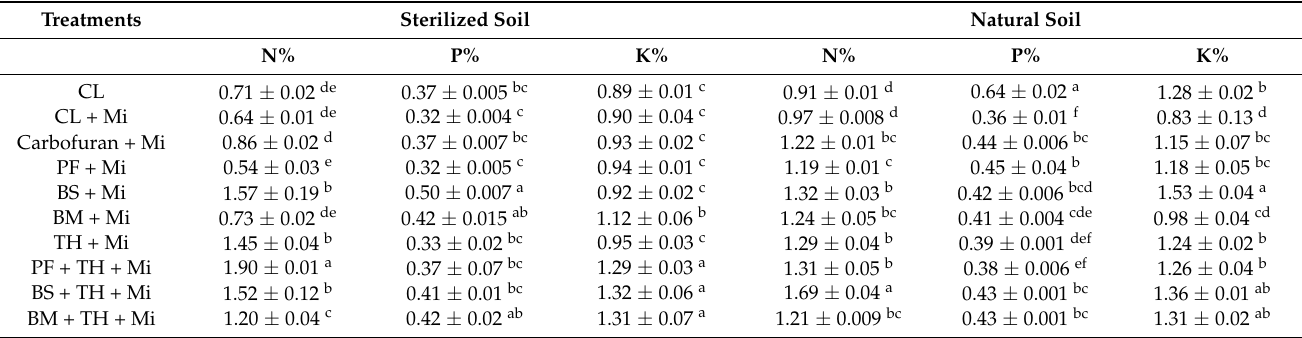
Table 5. Nutrient uptake (N, P and K, in %weight) under sterile and natural soil conditions. Treatments Sterilized Soil Natural